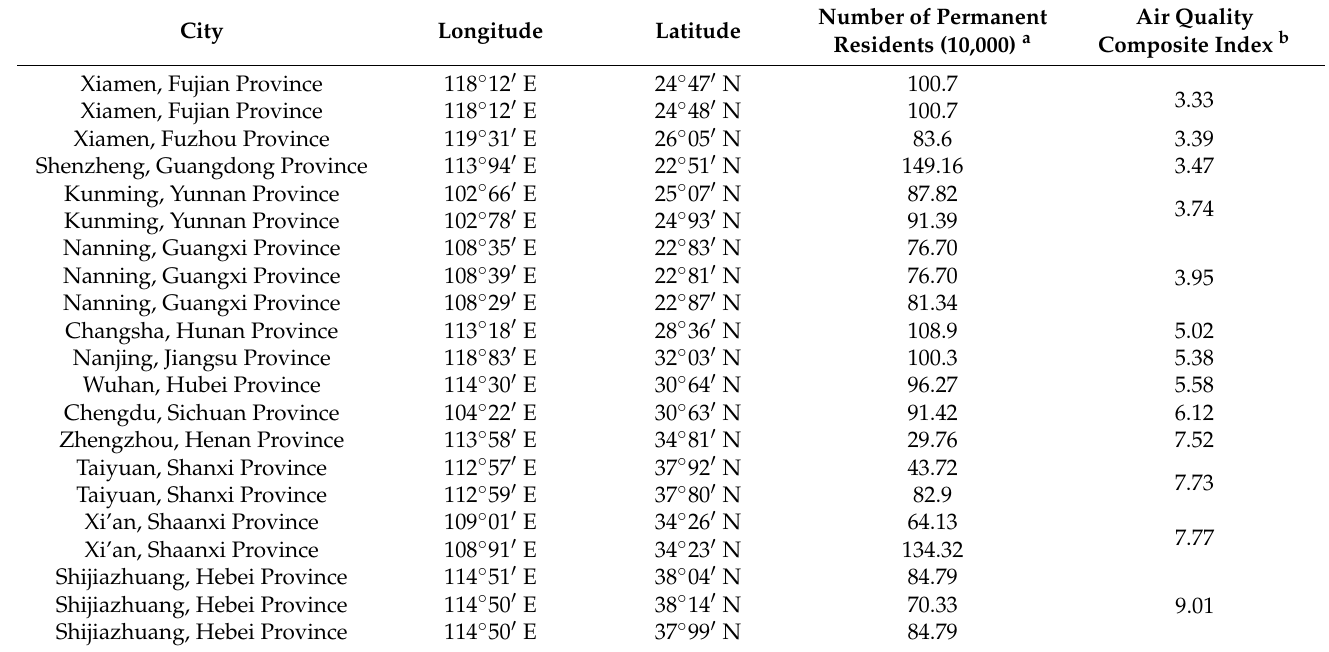
Table A1. Information for the study sites.